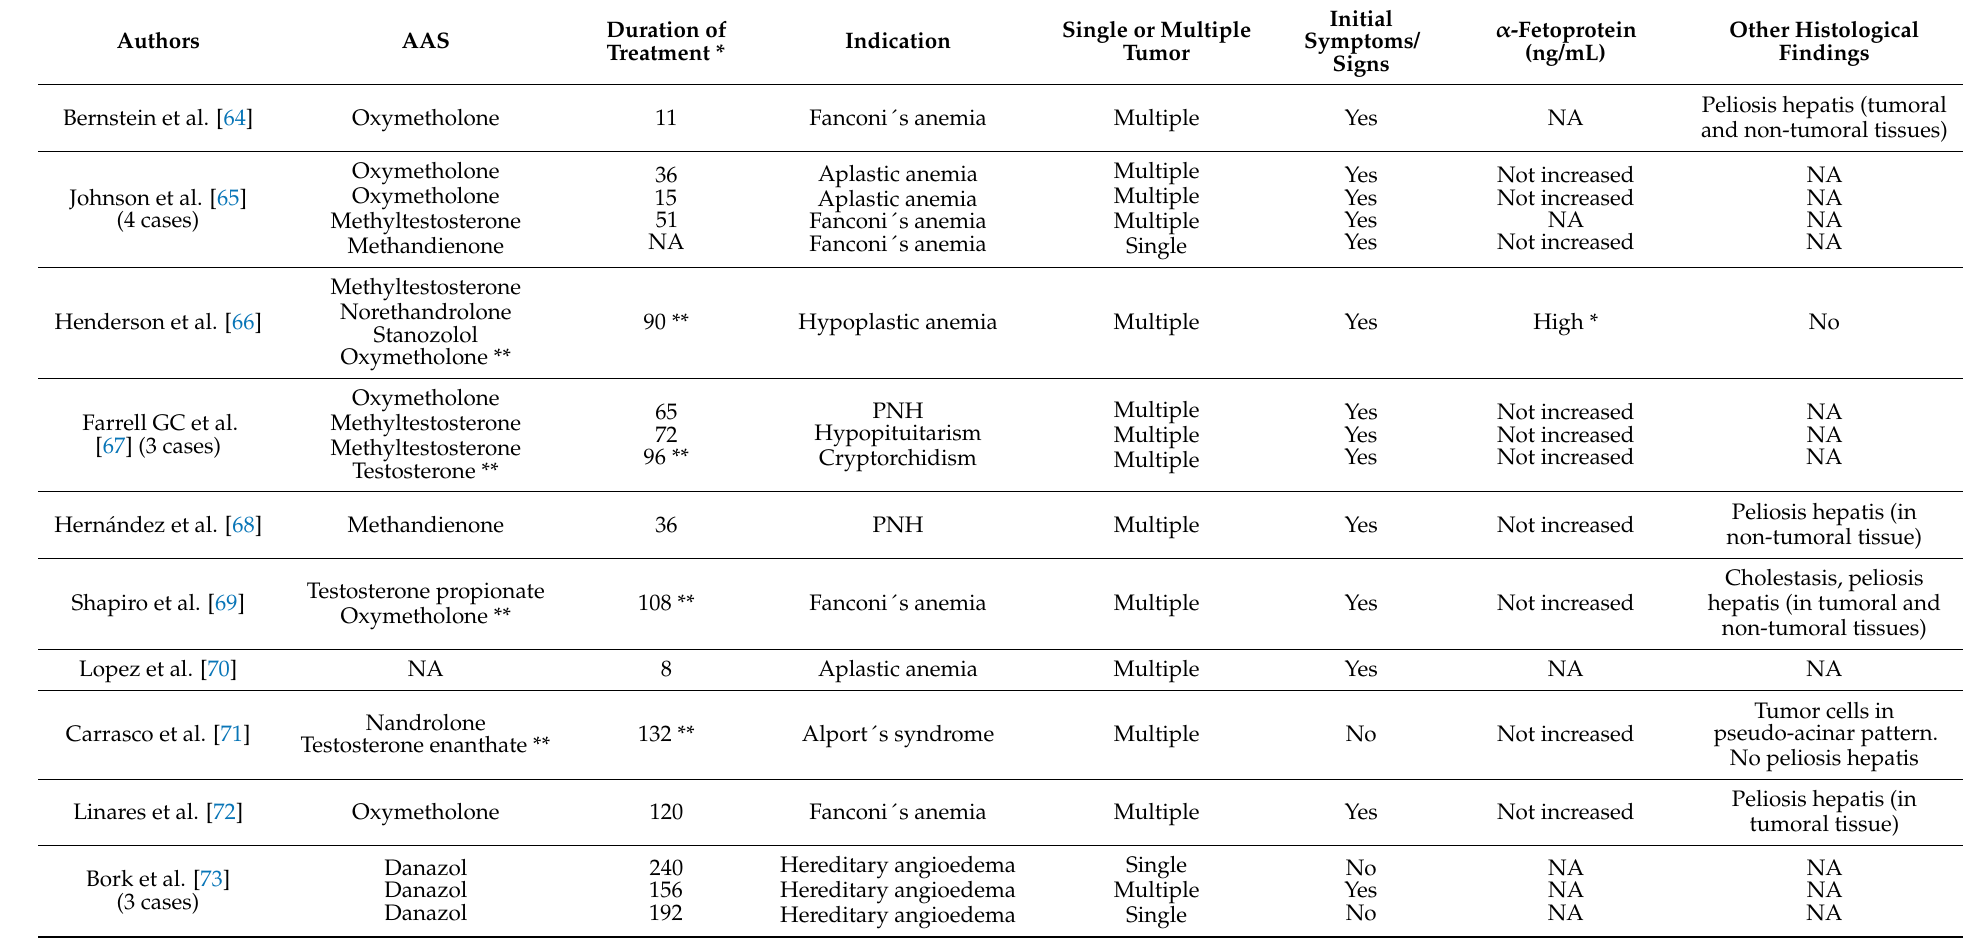
Table 2. Cases of anabolic-androgenic-steroid-related liver tumors reported in the